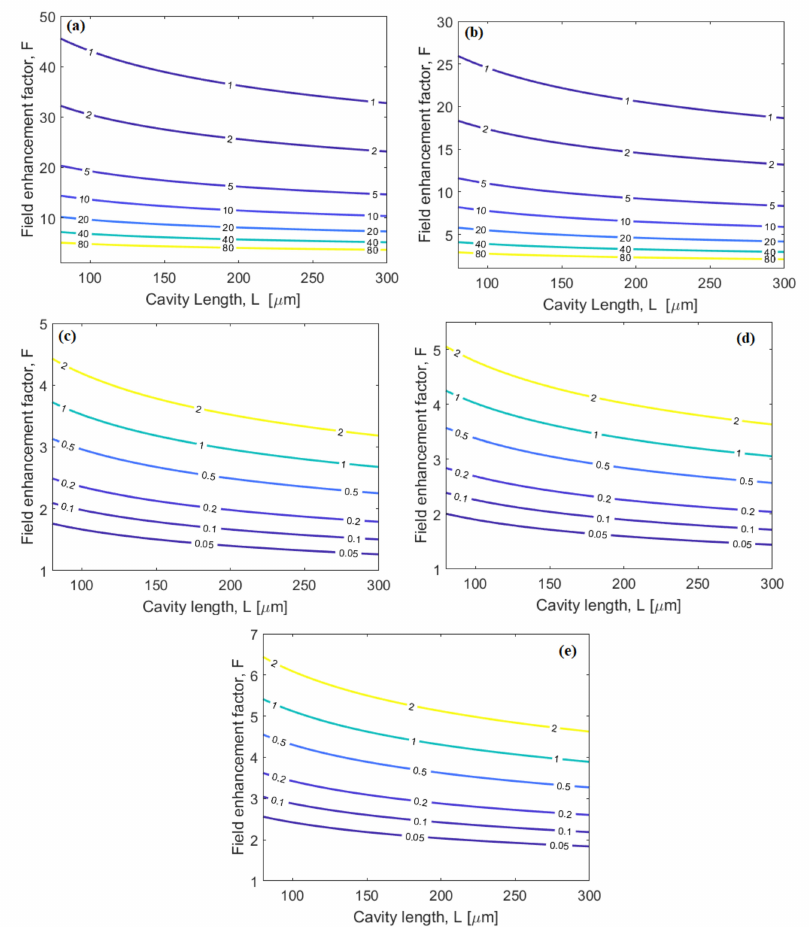
Figure 4. ( a , b ) Level curves of min { P TPA , P FCA } in the plane ( L , F ), silicon-on-insulator (SOI) and silicon-on-sapphire (SOS) platforms, respectively. The values are expressed in mW; ( c–e ) level curves of squeezing parameter r , in the plane ( L , F ), for SOI, SOS, and silicon nitride-on-SiO 2 -on Si (SiN) platforms,